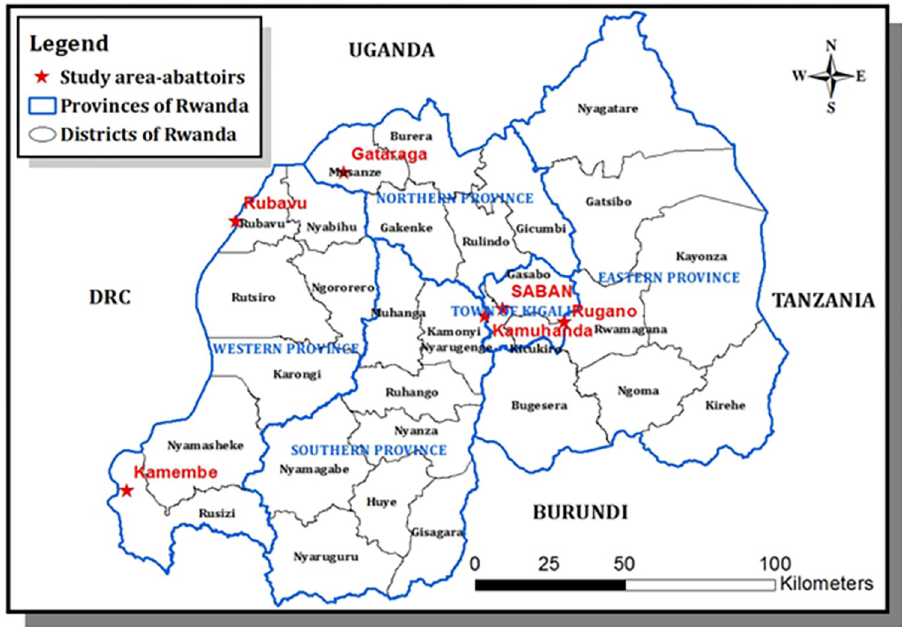
Fig 1. A map of Rwanda with provinces and districts with red stars showing the locations of abattoirs visited in this study [22].